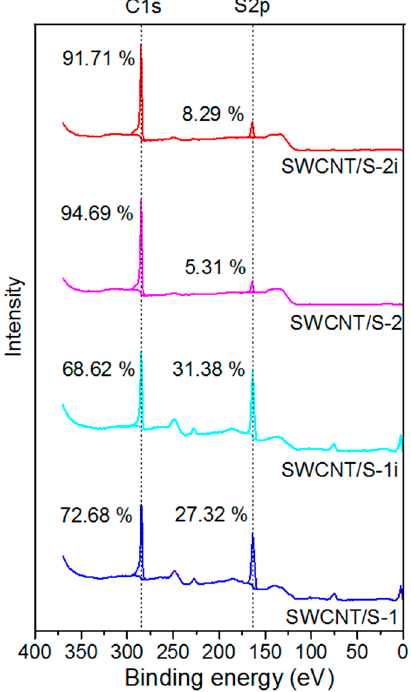
Figure 3. Overall XPS spectra of sulfur-contained SWCNTs before and after illumination.